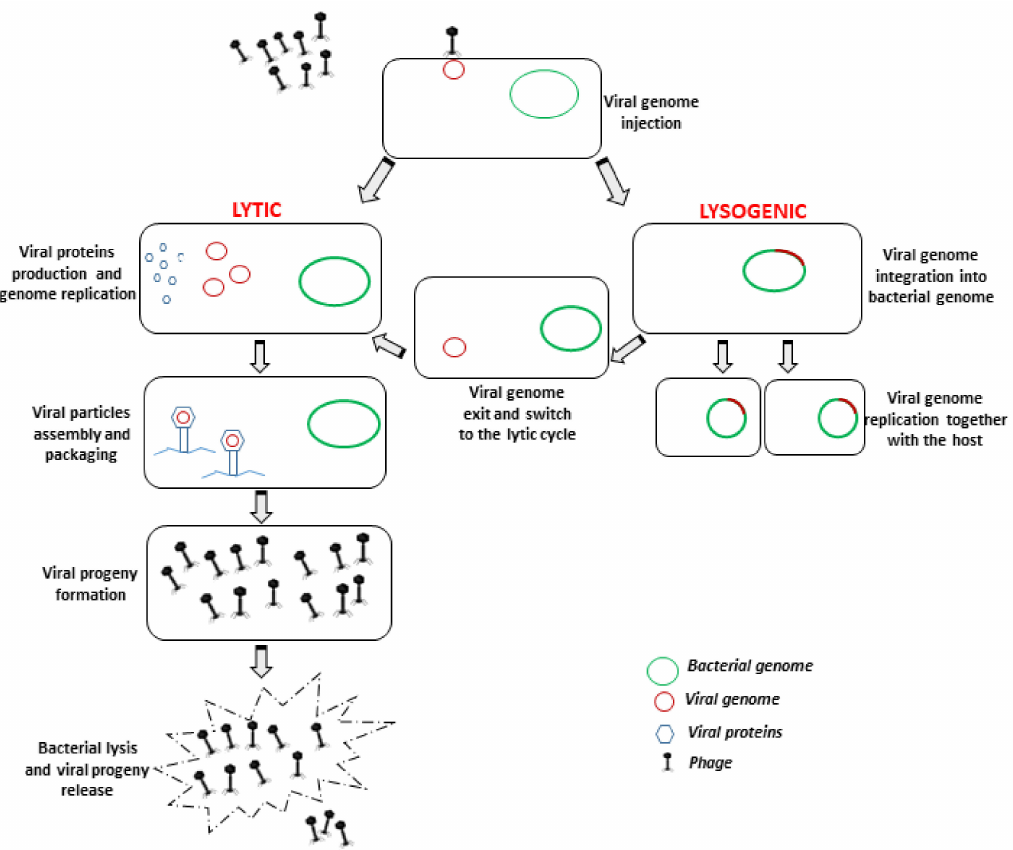
Figure 1. Schematic representation of bacteriophage lytic and lysogenic lifecycles, respectively carried out by virulent (lytic) and temperate (lysogenic) bacteriophages. Only lytic bacteriophages are suitable for decontamination/therapy